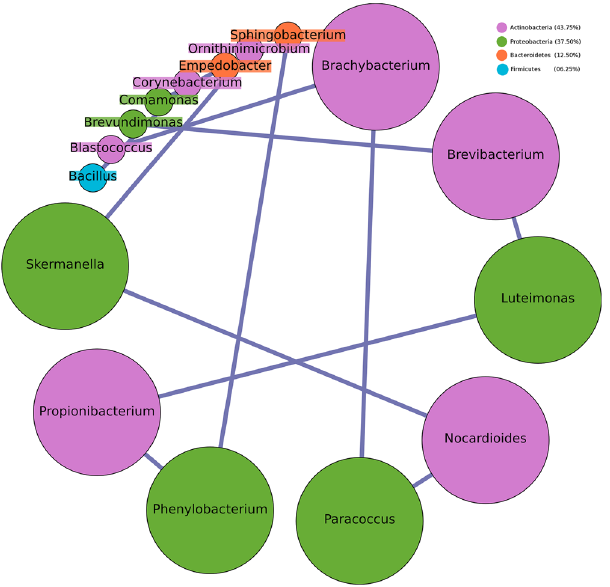
Figure 11. Degree sorted community network structure for samples pertaining to Healthy (control) set from Miraj location. Nodes were colored according to their phylum affiliation. Genera belonging to Actinobacteria phylum were observed to predominate the network in terms of membership. Top degree nodes of the co-occurrence network were observed to be affiliated to Actinobacteria and Proteobacteria. Graphs were generated using Gephi v